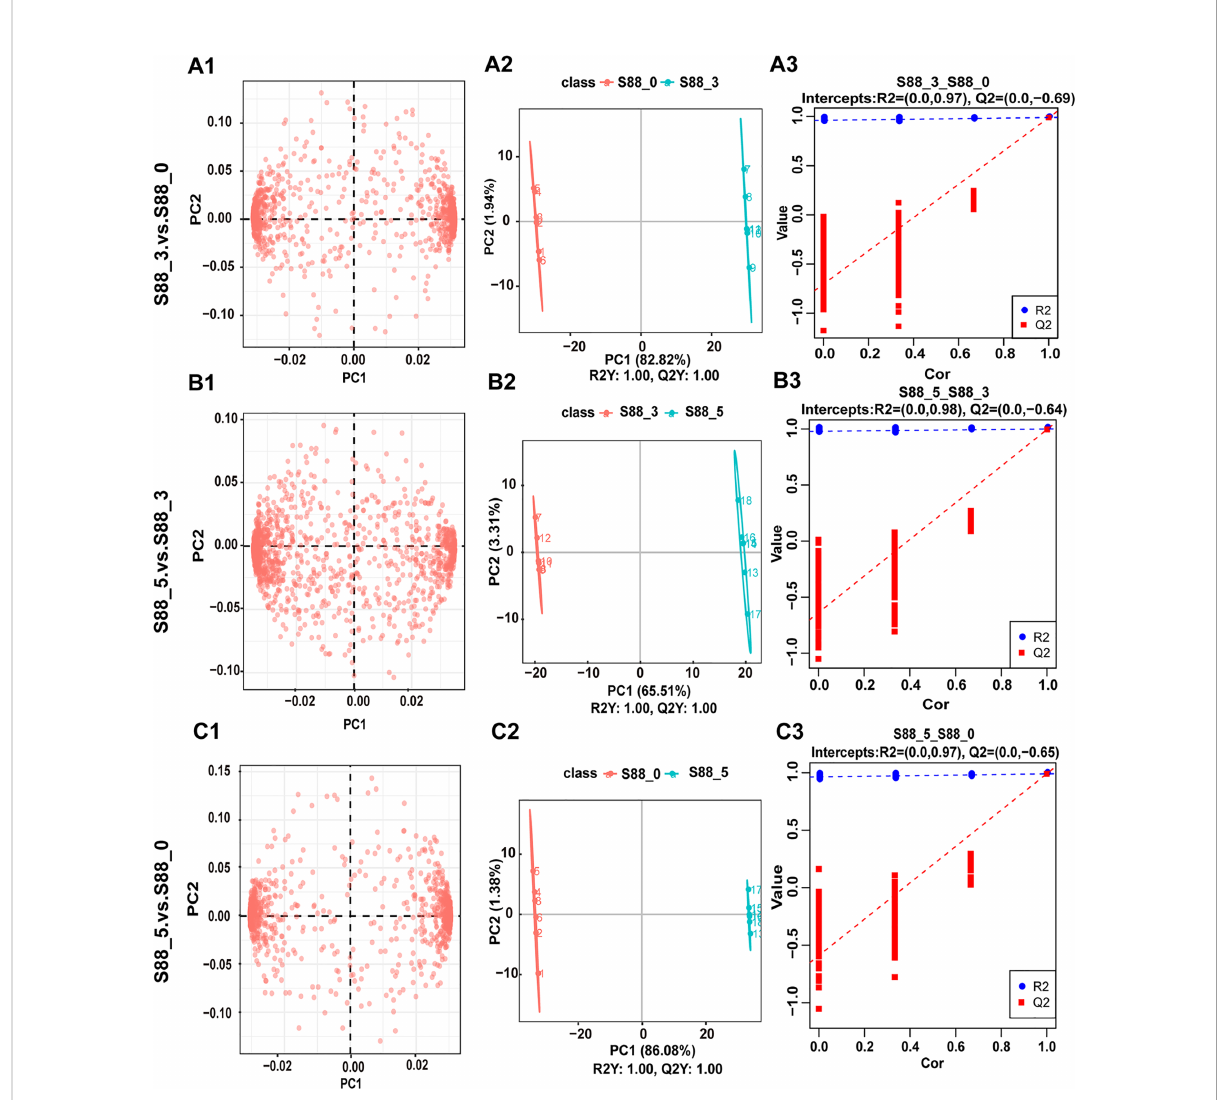
FIGURE 5 Statistical analysis for metabolite differences among three comparison groups after F. fujikuroi infection . Metabolic data of soybean seeds induced by F. fujikuroi were statistically analyzed among three comparison groups including S88_3.vs.S88_0, S88_5.vs.S88_3, and S88_5.vs.S88_0. (A1 – A3) PCA loading plots. (B1 – B3) PLS-DA score plots. (C1 – C3) PLS-DA valid